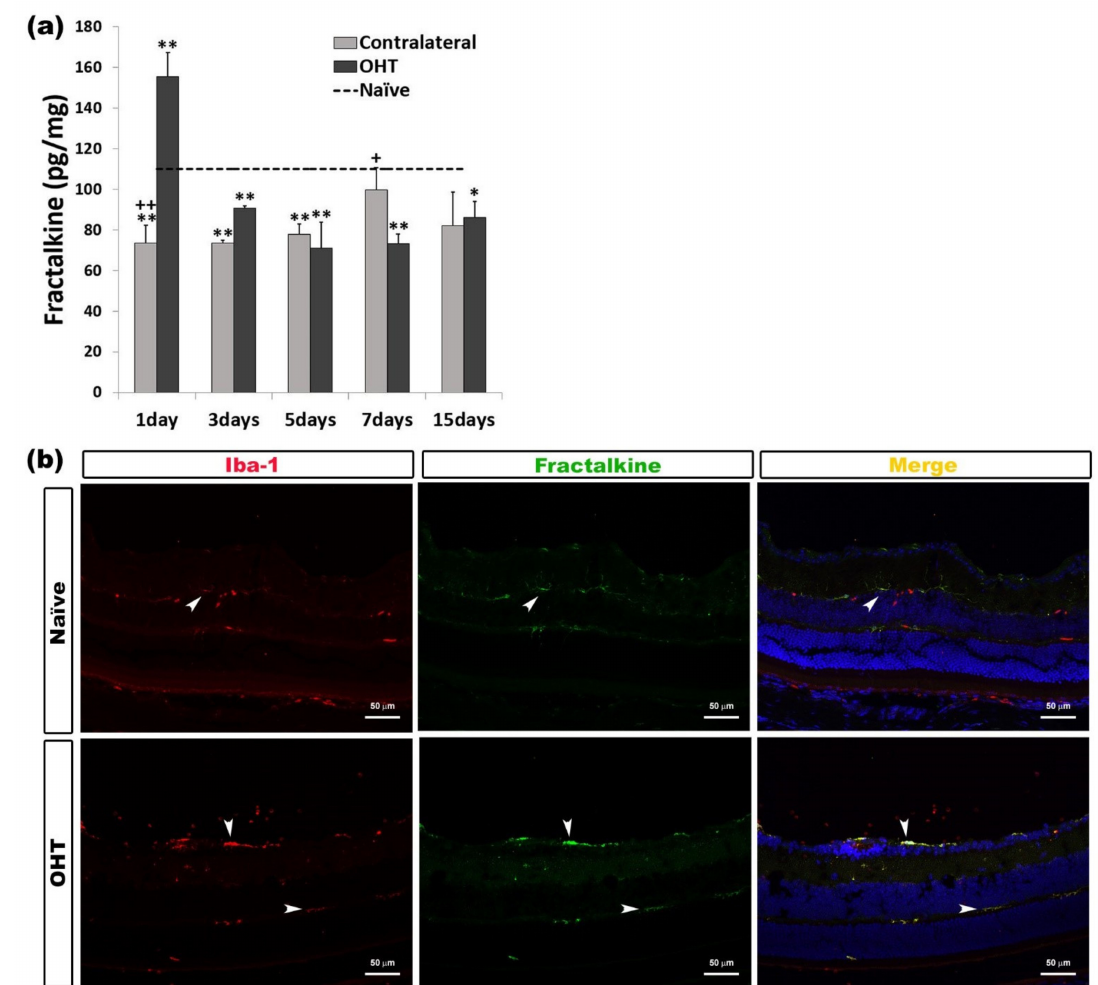
Figure 11. Fractalkine levels at different times after laser-induced ocular hypertension (OHT). ( a ) The variation over time in the fractalkine levels in the multiplex assay. The histograms show the mean levels ( ± SD) of fractalkine (pg/mg) at days 1, 3, 5, 7, and 15 after laser OHT induction, in ocular hypertension eyes (OHT) and in contralateral eyes. The dashed line indicates the mean levels in naïve eyes. Statistical significance indicators: * p < 0.05, ** p < 0.01 vs. naïve; + p < 0.05, ++ p < 0.01 vs. OHT. ( b ) Immunohistochemical study of fractalkine expression in OHT eyes one day after unilateral laser-induced OHT. Retinal sections were immunolabeled with antibodies to fractalkine (green) and Iba-1 (red). Merge (yellow). The arrowheads indicate the co-expression of Iba-1 and fractalkine in OHT eyes and naïve eyes; it is more intense in OHT eyes. Abbreviations: OHT (ocular hypertension); Iba-1 (ionized calcium-binding adaptor molecule